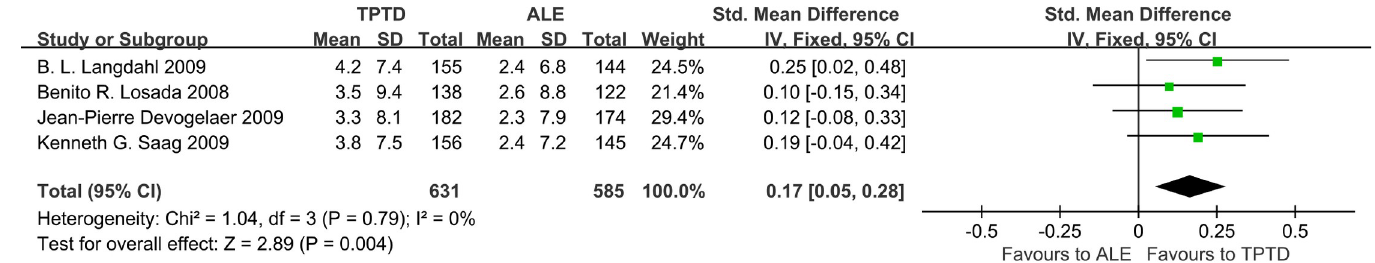
Fig 8. Forest plots of mean percent change from baseline to 18 months in the TH